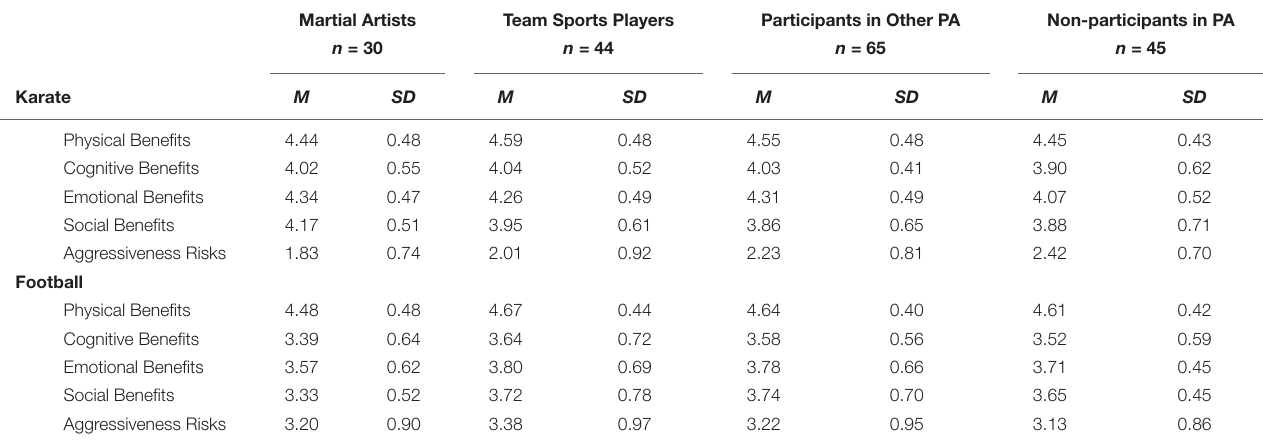
TABLE 4 | Perceived benefits and aggressiveness risks of karate and football by type of participation in PA. Martial Artists Team Sports Players Participants in Other PA Non-participants in